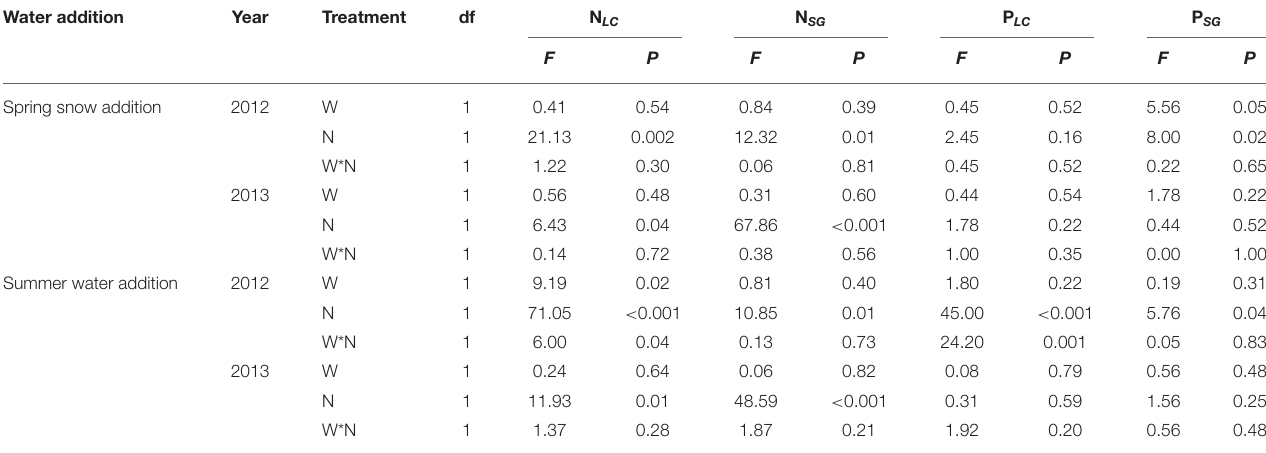
TABLE 3 | Results ( F- and P -values) of two-way ANOVA on the effects of water (W; including spring snow and summer water), N application (N), and their interactions on leaf N concentration (N leaf , %) and leaf P concentration (P leaf , %) of Leymus chinensis (N LC and P LC ) and Stipa grandis (N SG and P SG ) in 2012 and 2013. Water addition Year Treatment